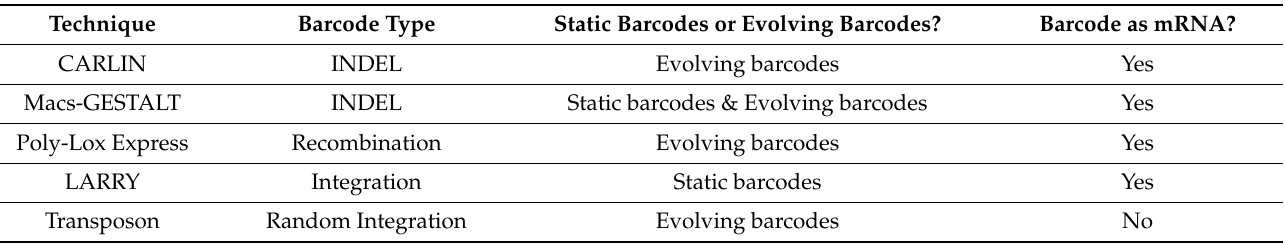
Table 1. Molecular Barcoding Strategies. The tables summarize recently established evolving barcodes. Once barcodes are transcribed as mRNAs, single-cell RNA-seq could deconvolute both lineage trajectory and cell type taxonomy.